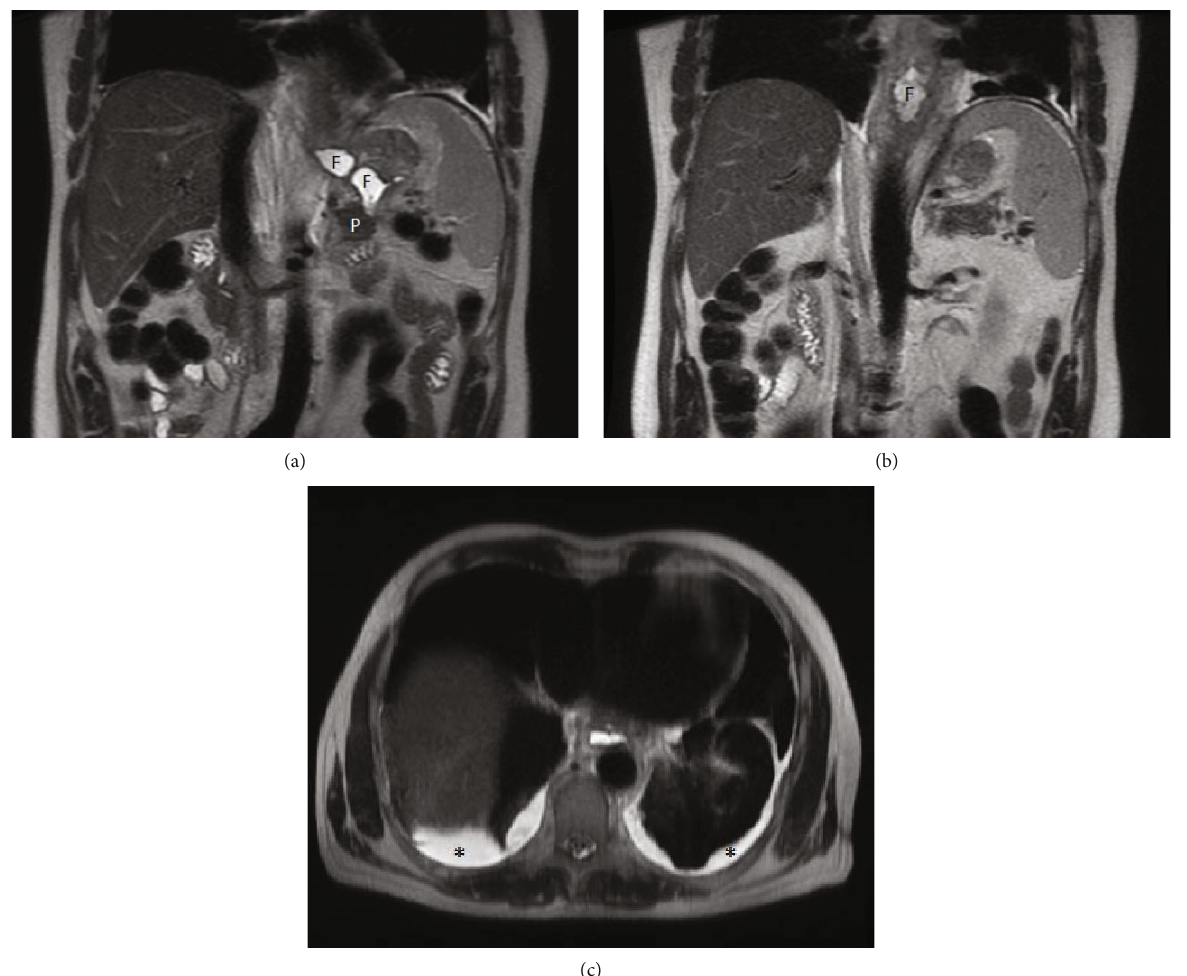
Figure 1: Magnetic resonance. Coronal and axial T2 single shot fast spin echo sequences revealed retroperitoneal peripancreatic fl uid collections (a) extending to mediastinum (b) and free fl uid in both pleural cavities (c). P: pancreas; F: fl uid collection. ∗ Free fl uid in pleural